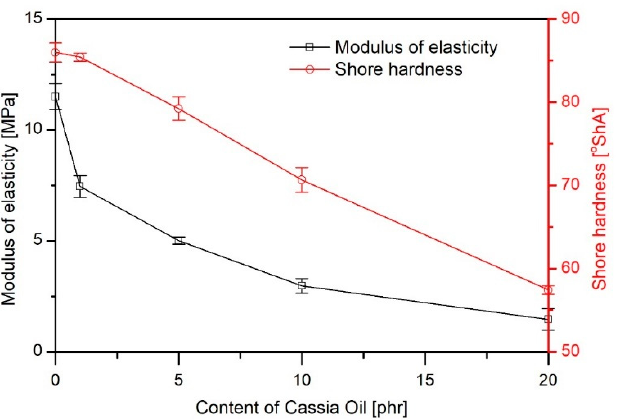
Figure 4. Modulus of elasticity and Shore hardness as a function of CO in the PVC matrix.